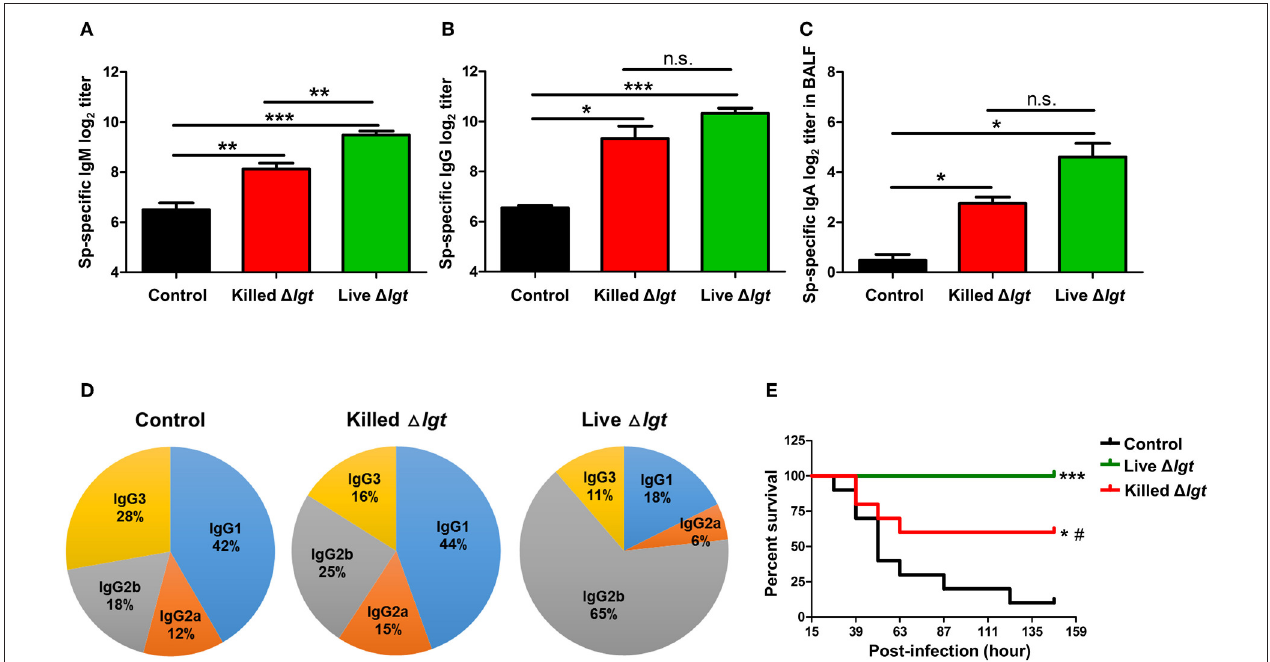
FIGURE 3 | Humoral and Mucosal Protective Immune Responses Induced by Live 1 lgt Vaccination. (A–D) Levels of Sp -specific serum IgM (A) , serum IgG (B) , and BALF IgA (C) and ratios of serum IgG subclasses (D) determined 10 days after second immunization in mice ( n = 5 per group) i.n. immunized twice with killed 1 lgt or live 1 lgt at 14-day intervals. Data in (A–C) indicate mean values ± S.D. n.s.; not significant, * P < 0.05, ** P < 0.01, and *** P < 0.001 compared to PBS-inoculated controls. (E) Survival of mice ( n = 5 per group) i.n. immunized twice with killed 1 lgt or live 1 lgt at 14-day intervals, followed by intraperitoneal (i.p.) challenge with 10 7 CFU of wild-type TIGR4. * P < 0.05 and *** P < 0.001 compared to control groups immunized with PBS. # P < 0.05 compared to the live 1 lgt -vaccinated